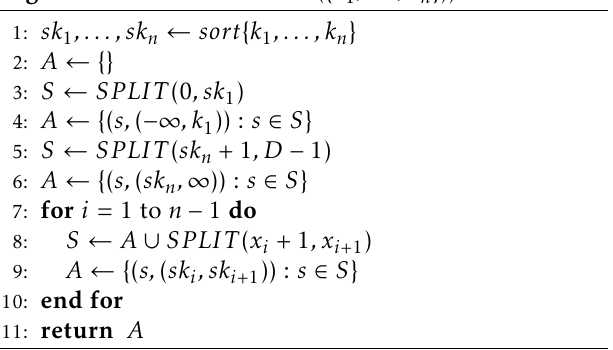
Algorithm 2 ALLP REFIXES ( { k 1 , . . . , k